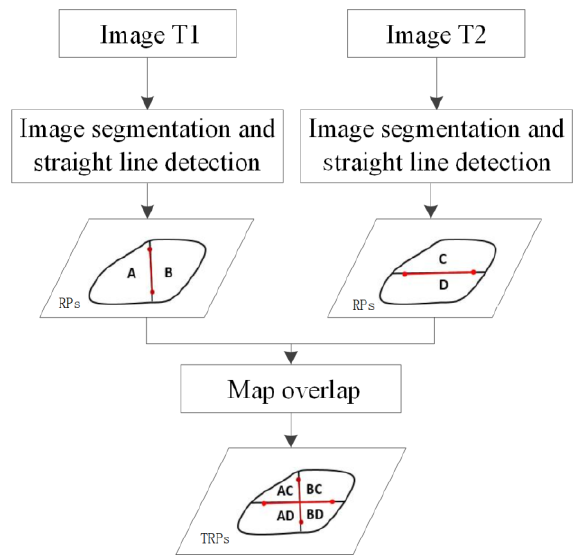
Figure 1. Technical framework. Remote Sens. 2019 , 11 , x FOR PEER REVIEW